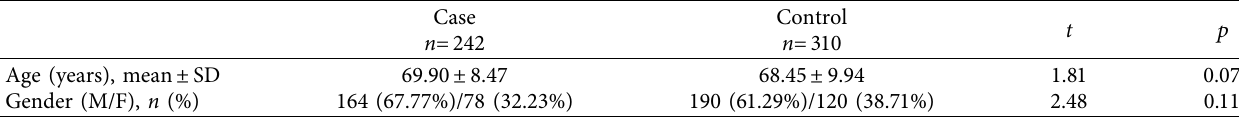
Table 1: The baseline of the two groups.